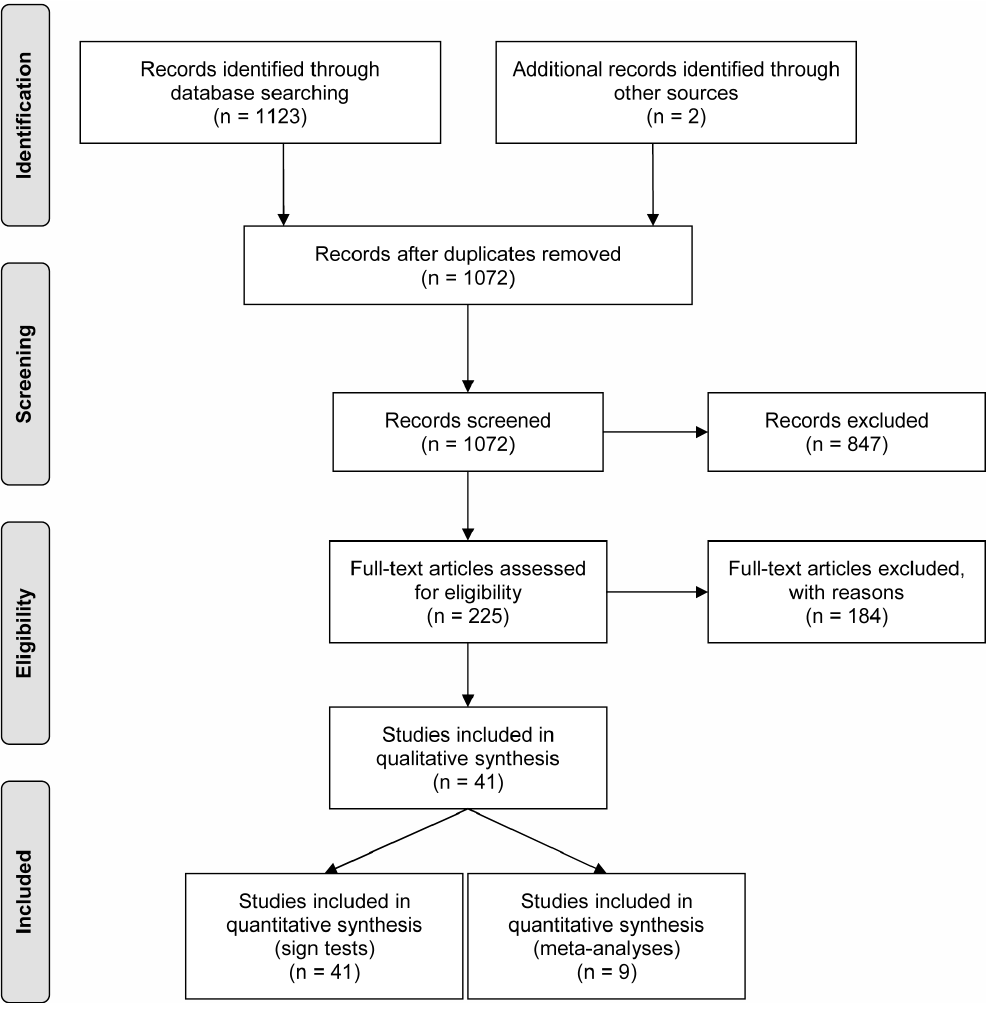
Figure 2. PRISMA Literature Search Flow Diagram.